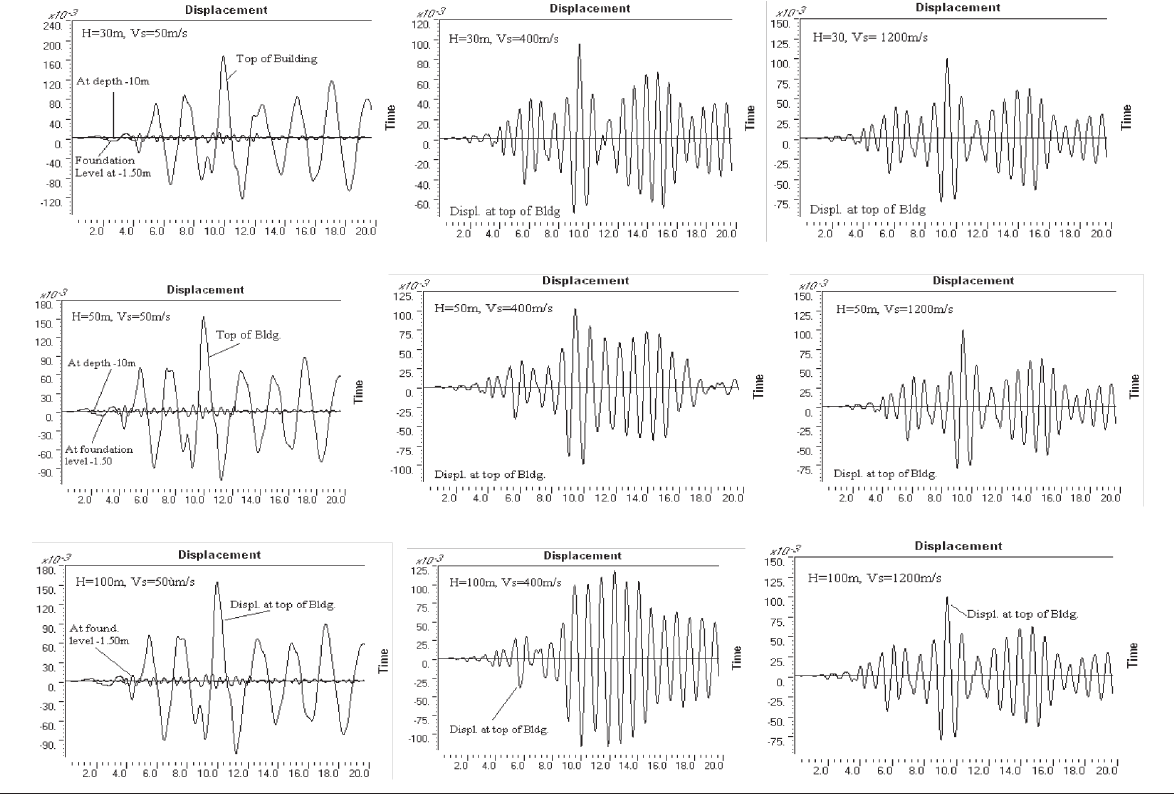
(cid:18)!.(cid:9)1) (cid:5)(cid:6)(cid:10)(cid:25);(cid:11)(cid:8)(cid:19)(cid:21)(cid:22)(cid:21)(cid:17)(cid:14)(cid:5)(cid:14)(cid:10)(cid:22)(cid:21)(cid:5)(cid:15)(cid:10)(cid:25)(cid:14)(cid:3)(cid:2)(cid:23)(cid:5);(cid:11)(cid:3)(cid:14)(cid:25)(cid:5)(cid:4)(cid:3)(cid:2)(cid:5) 1 (cid:5)T(cid:5)&$(cid:12)(cid:5)9$(cid:12)(cid:5)"$$(cid:5)(cid:22)P(cid:5) 8? (cid:5)T(cid:5)9$(cid:12)(cid:5).$$(cid:12)(cid:5)"%$$(cid:5)(cid:22)L(cid:25)